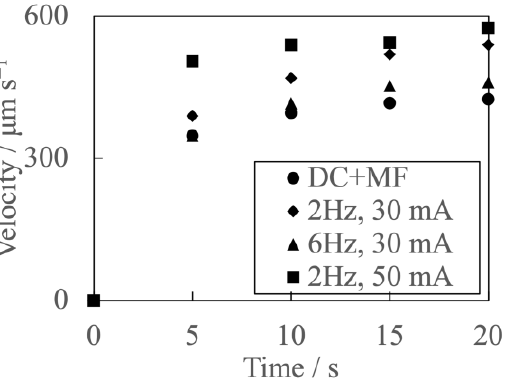
Figure 4. Maximum velocity measurement results in x -range of − 4 mm to 4 mm and y -range of 120 μm to 280 μm .